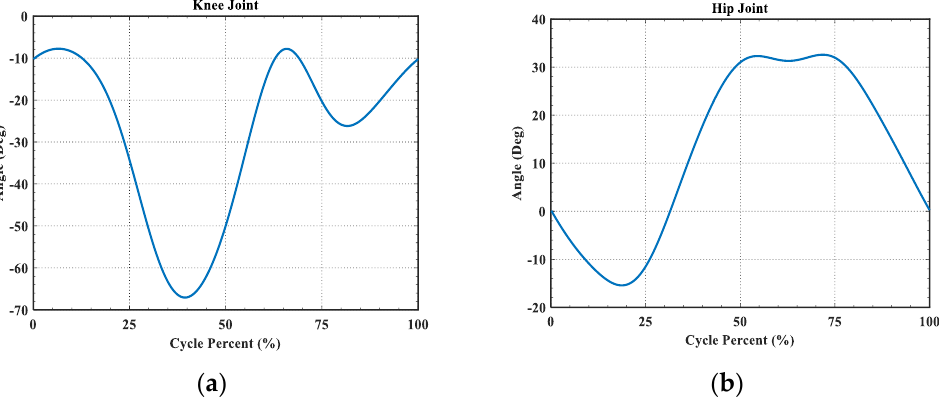
Figure 10. The ideal gait trajectory of the lower limb in the sagittal plane. ( a ) The ideal joint trajectory of the knee; ( b ) the ideal joint trajectory of the hip joint.